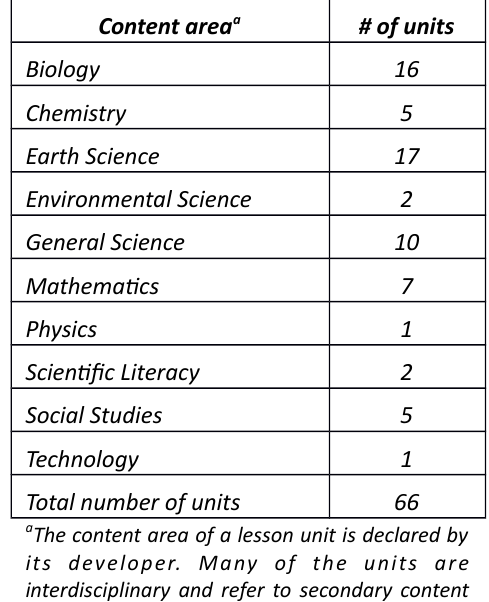
Table 1. Summary of ICCARS climate change lesson units by content